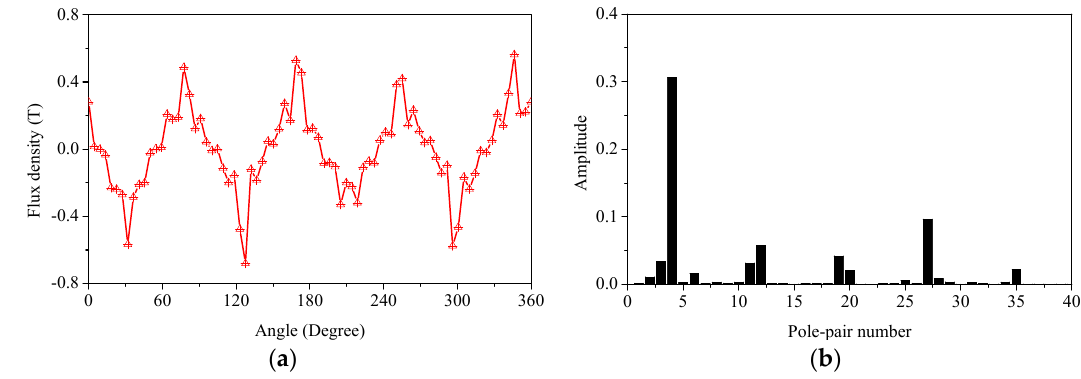
Figure 13. Airgap flux density in the outer airgap due to the inner rotor PMs: ( a ) flux density; and ( b ) harmonic spectrum.